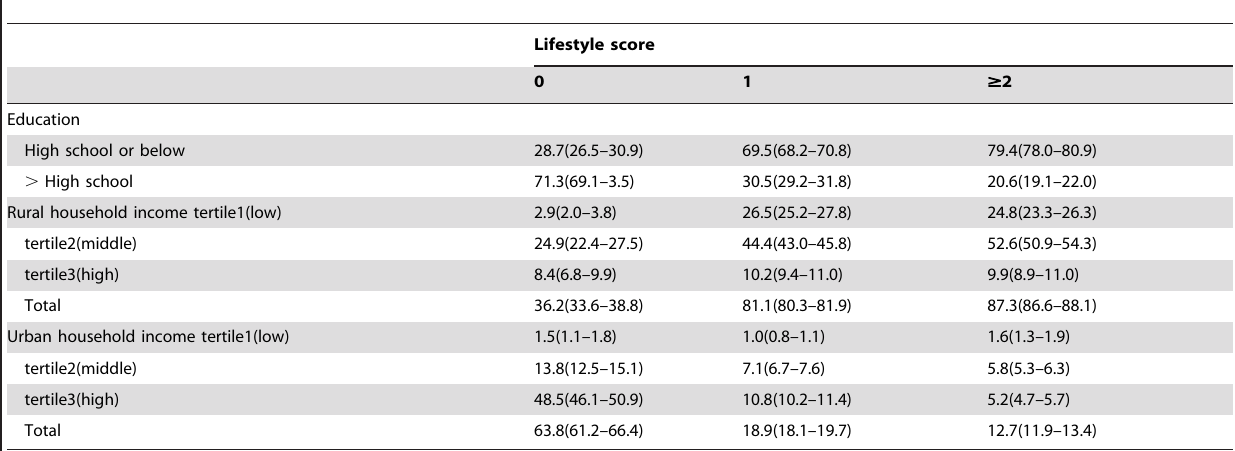
Table 3. Relationship between lifestyles and socioeconomic status.